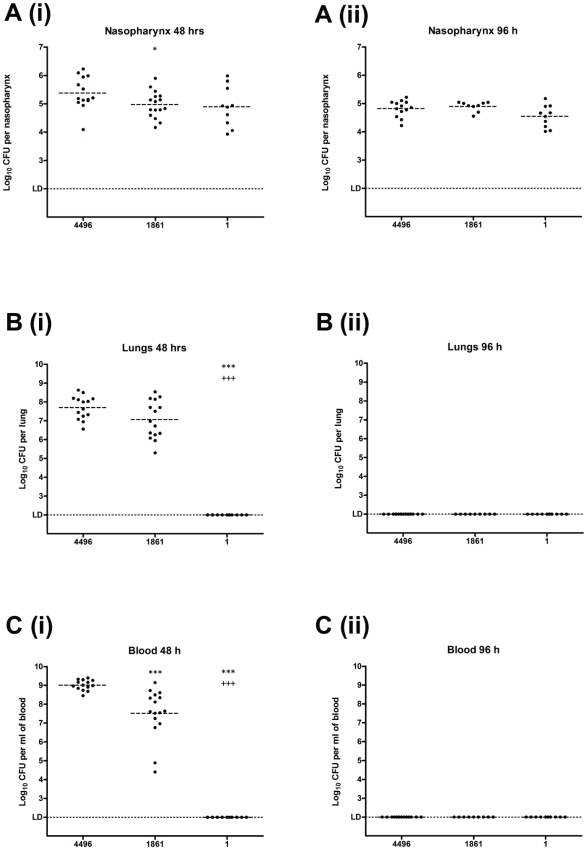
Number of S. pneumoniae CFU recovered from the nasopharynx, lungs and blood of infected mice.The number of CFU recovered from the nasopharynx (A), lungs (B) and blood (C) of CD1 mice was determined at 48 h (i) and 96 h (ii) post-challenge. The horizontal broken lines in each strain group indicate the geometric mean number of CFU that were recovered. Statistical differences were analyzed by two-tailed unpaired t-test on log-transformed values (*, P<0.05; **, P<0.01; ***, +++ P<0.001). ‘*’ indicates comparison with 4496 and ‘+’ indicates comparison with 1861. The single horizontal spotted line indicates the limit of detection (LD) which equates to 102 CFU/nasopharynx, 2×102 CFU/lung and 102 CFU/ml blood.